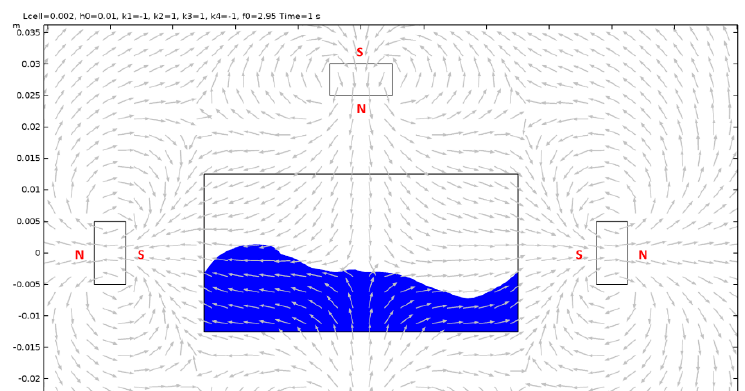
Figure A22. Case 8.